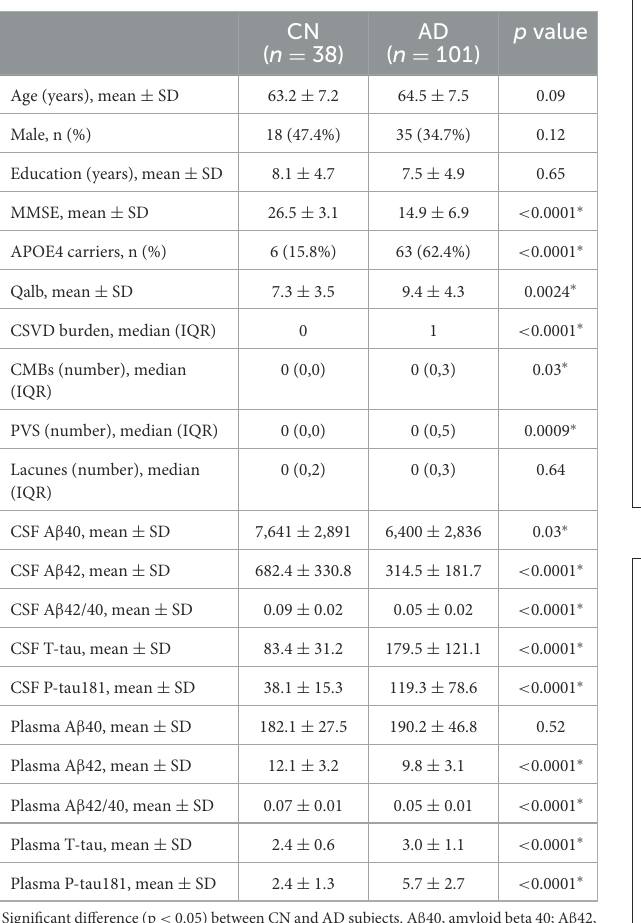
TABLE 1 Demographic characteristics and fluid biomarkers of subjects.